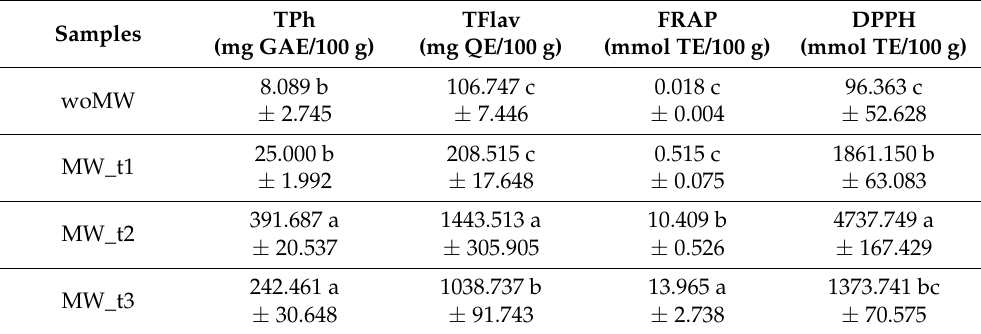
Table 2. Mean results of total polyphenols (TPh), total flavonoid (TFlav) content, and antioxidant capacity (FRAP and DPPH) results from one-way ANOVA ( p = 0.05) *.